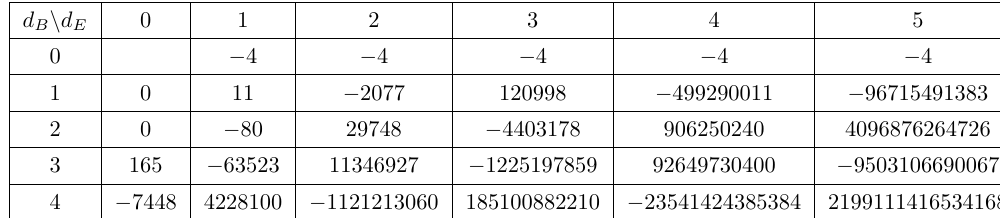
for the genus ( g ) = (1 , 1) . L , g R ( d B ,d E )